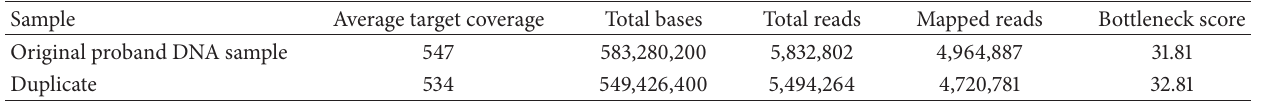
Table 1: Summary of coverage for analyzed samples by next generation sequencing